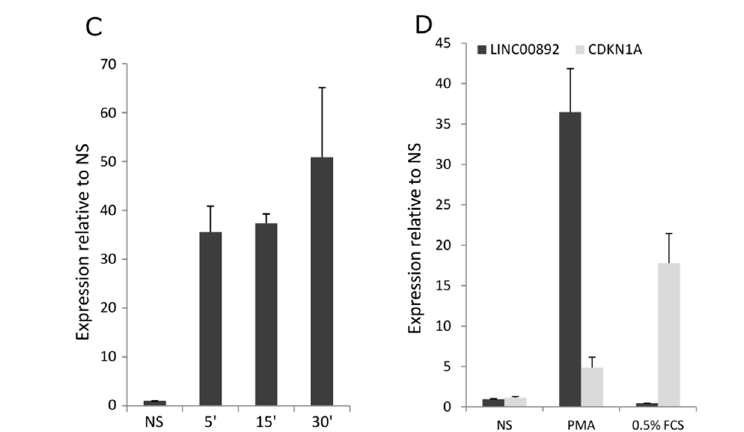
Figure 6. LINC00892 induction is late and persistent. ( A ) RT-qPCR analysis of LINC00892 expression in Jurkat cells left untreated (NS), stimulated with PMA/ionomycin for 3 h (ST1), washed and collected after the indicated hours after stimulation, and after a second 3 h PMA/ionomycin stimulus (ST2). ( B ) RT-qPCR analysis of LINC00892 expression in Jurkat cells left untreated (NS), stimulated with PMA only, ionomycin only or both PMA and ionomycin for 3 h and collected 4 days after the stimulus. ( C ) RT-qPCR analysis of LINC00892 expression in Jurkat cells left untreated (NS), stimulated with PMA only for 5, 15 or 30 min and collected 4 days after the stimulus. ( D ) RT-qPCR analysis of LINC00892 and CDKN1A expression in Jurkat cells left untreated (NS), stimulated with PMA only for 3 h and collected 2 days after the stimulus (PMA) or cultivated for 48 h in medium containing 0.5% FCS. Experiments in A, B and C were performed in triplicate. The experiment in D was performed in duplicate.